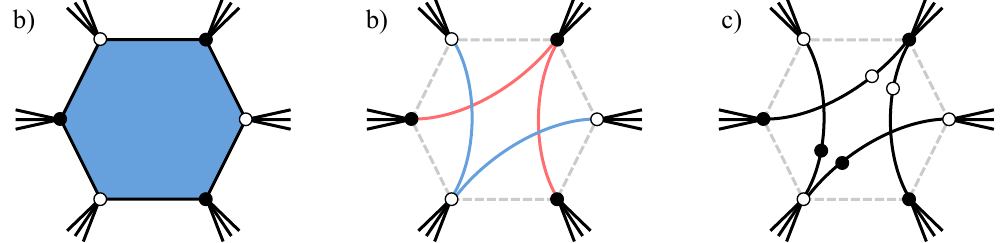
Figure 5. Backreaction of a local piece of a BFT surface around a D-brane instanton on a 6-edge face. Similar remarks to (cid:12)gure 4 apply, with the di(cid:11)erence that (cid:1) g = 2 in this